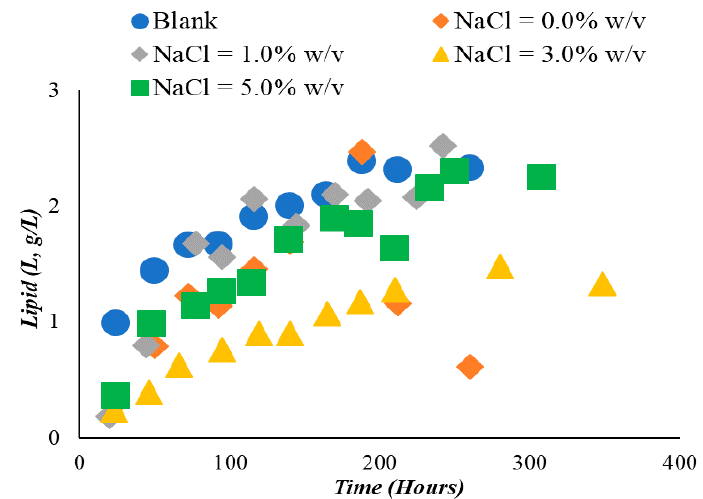
Figure 3. Single cell oil (SCO) production by Yarrowia lipolytica ACA-YC 5031 in culture medium containing blank glycerol and blended also with phenols and 0.0%, 1.0%, 3.0%, and 5.0% w/v NaCl.